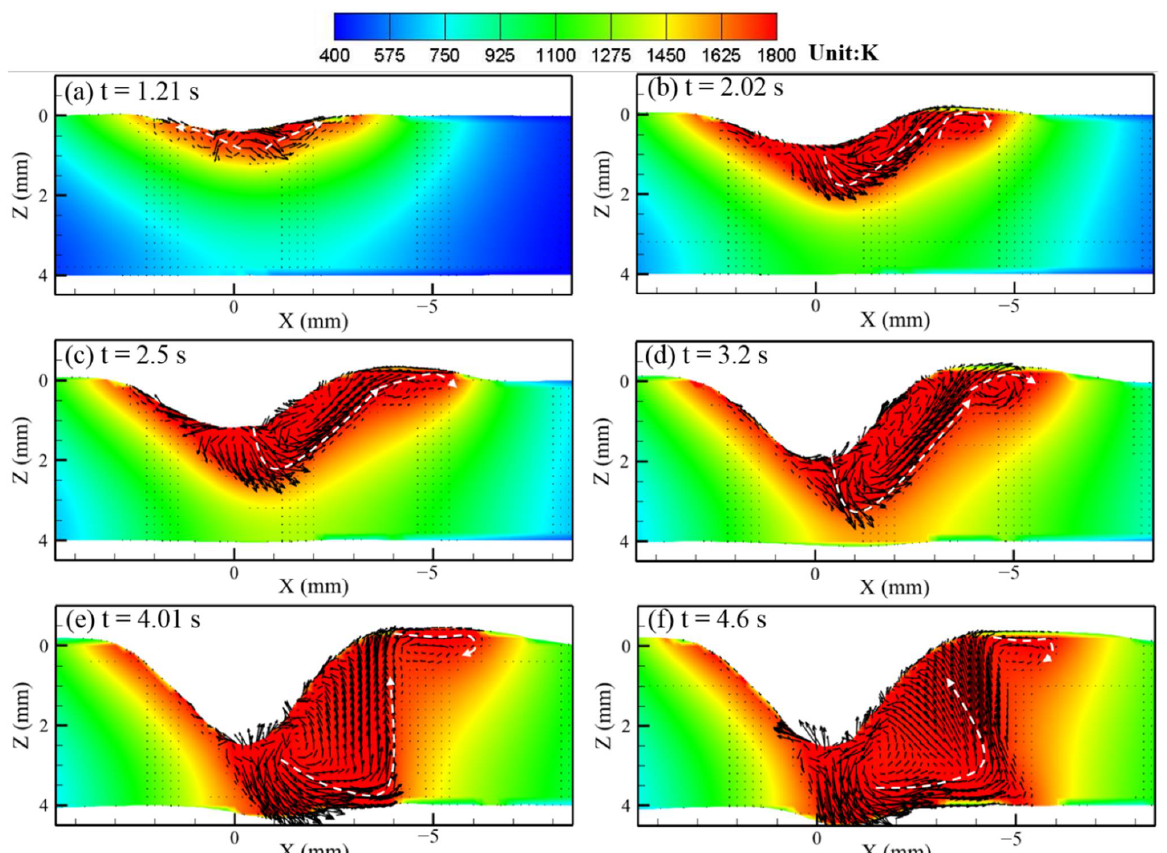
Figure 9. The calculated temperature field, fluid flow, and keyholing time in the PAW case. In U-PAW, due to the exerted ultrasonic vibration, the plasma jet velocity increases, and both the gas shear stress and arc pressure increase. Therefore, the ultrasonic-assisted plasma arc has a stronger keyholing capability. As shown in Figure 10, although the fluid flow trend in U-PAW is almost the same as that in PAW, an open keyhole is formed at an instant of 4.2 s. Figure 10f demonstrates that after the keyhole is formed, the liquid metal at the front keyhole wall is very thin, while there is more liquid metal on the rear wall of